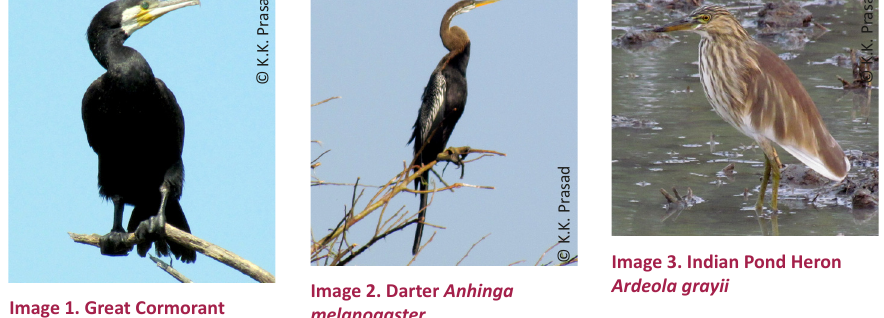
Image 1. Great Cormorant Phalacrocorax carbo